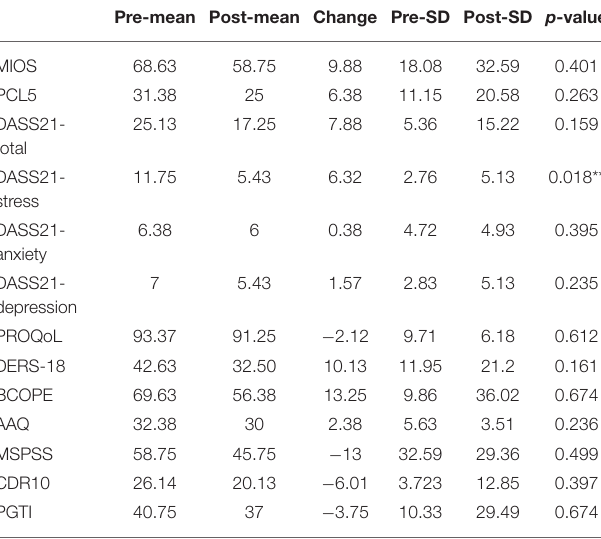
TABLE 2 | Participant demographics. TABLE 3 | Participants self-reported